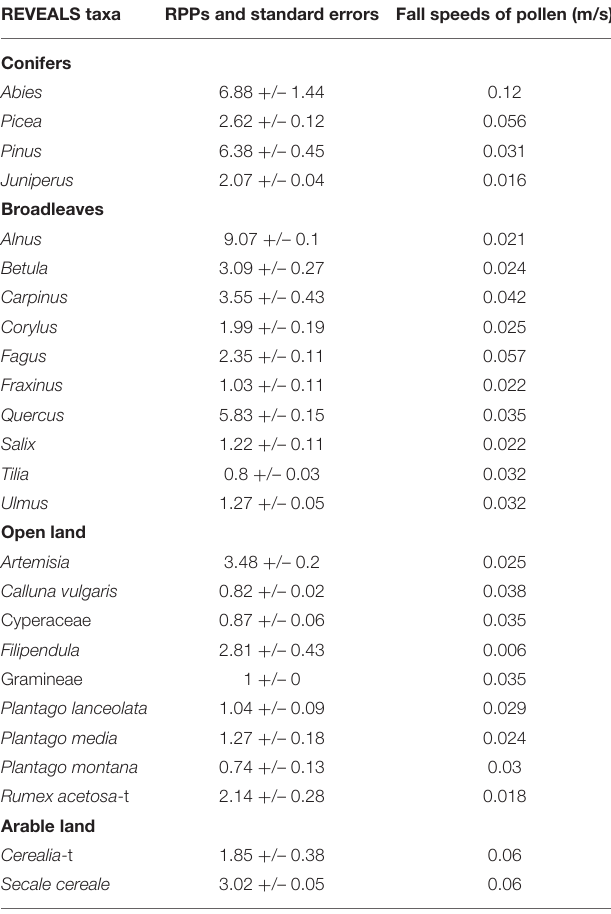
TABLE 1 | Taxa and groups of taxa used for the REVEALS reconstructions. REVEALS